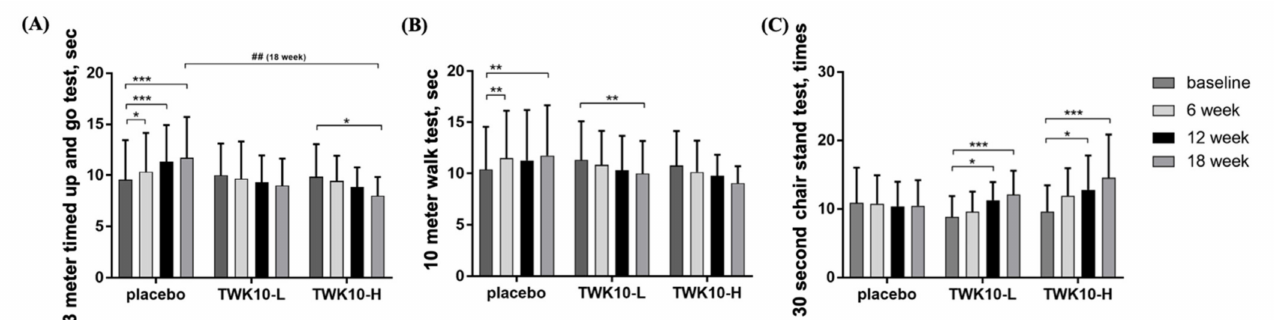
Figure 3. Effect of TWK10 supplementation in elderly on ( A ) 3 m timed up and go test, ( B ) 10 m walk test, and ( C ) 30 s chair stand test at baseline, 6th, 12th, and 18th weeks, respectively, in placebo group (n = 17), TWK10-L (n = 12), and TWK10-H (n = 13) groups. Data are expressed as mean ± SD. * p < 0.05, ** p < 0.01, *** p < 0.001 vs. baseline of each group. ## p < 0.01 vs. between groups at same time